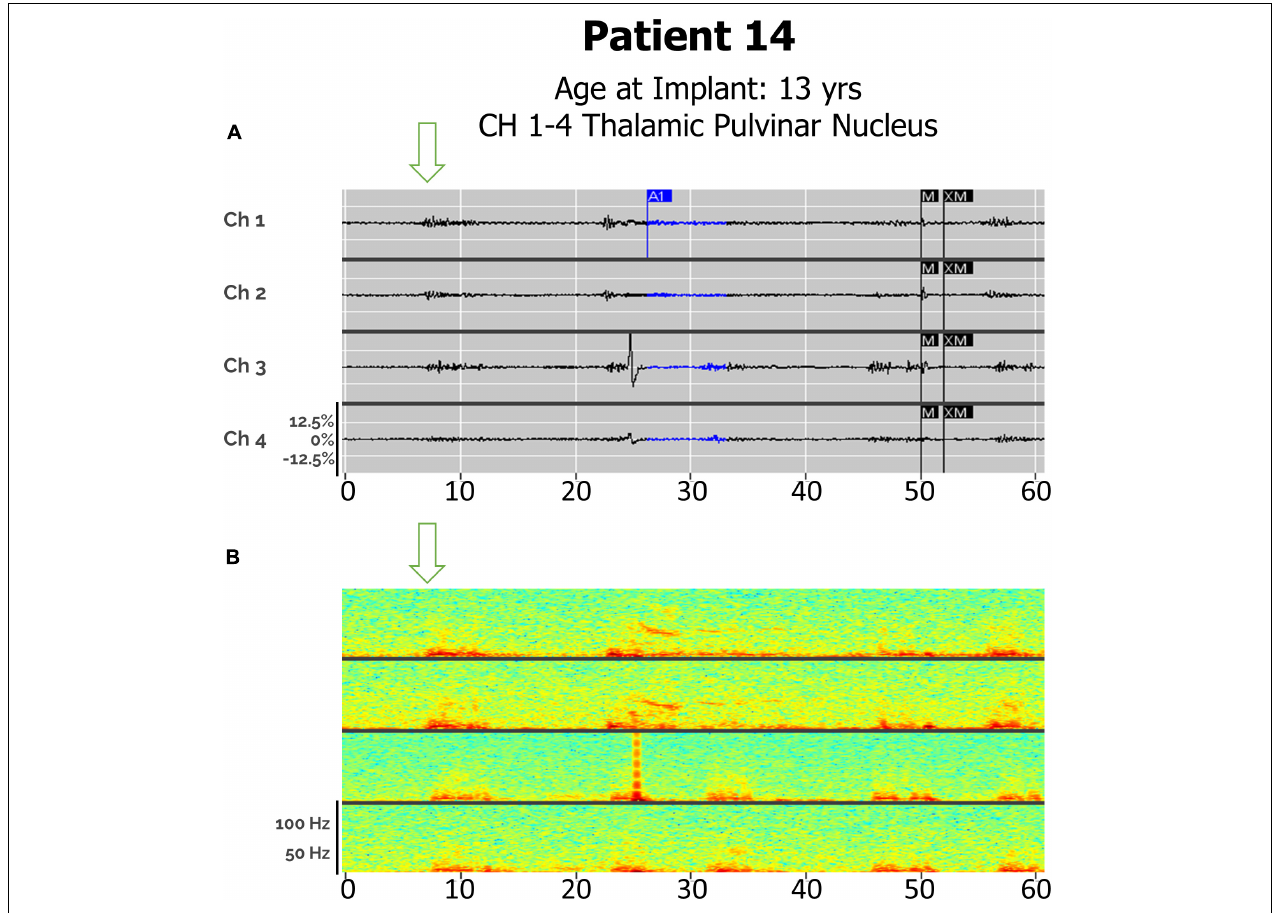
FIGURE 6 | (A) Electroclinical seizure detections in Patient 14 captured with bilateral pulvinar (Pulv) leads over an 60-s window, demonstrating both a clinical generalized seizures (Drop), with in-phase waveforms, and focal seizures (left arm fencing posture), with out-of-phase waveforms. Arrows denote seizure onsets. Ch1. L-Pulv1–L-Pulv2; Ch 2. L-Pulv3–LPulv4; Ch 3. R-Pulv1–R-Pulv2; Ch 4. R-Pulv3–R-Pulv4. (B) Spectrogram of same